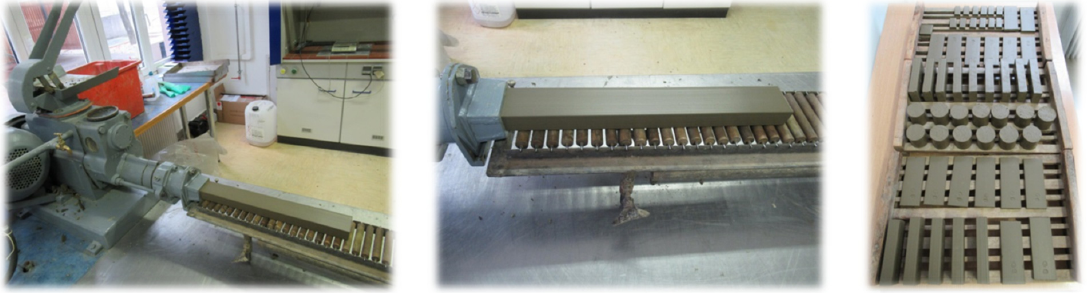
Figure 5. Sample preparation with a de-airing extruder. Table 3. Properties of the dried and fired